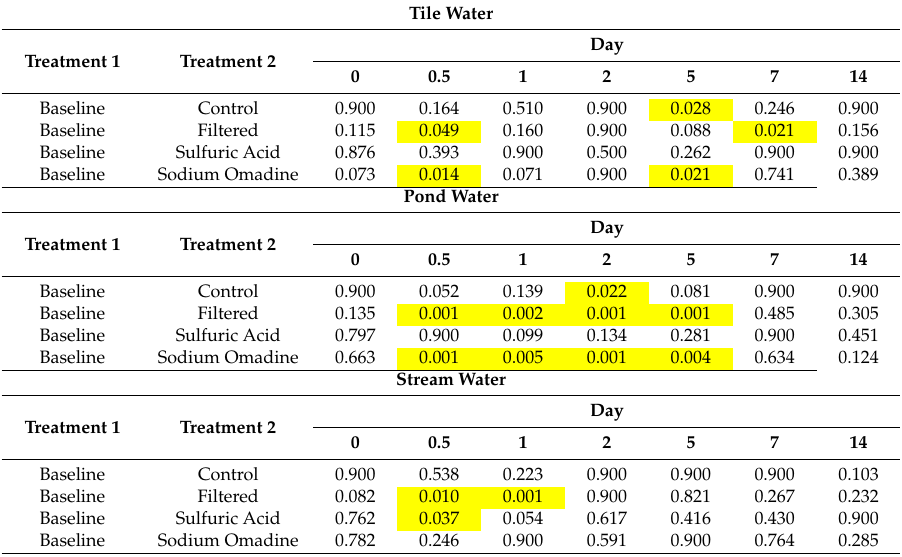
Table 6. Significant differences between methods for orthophosphate measurement were calculated using Tukey HSD method and the p -values are presented for each treatment comparison and day. Significant differences ( p < 0.05) are highlighted in yellow for